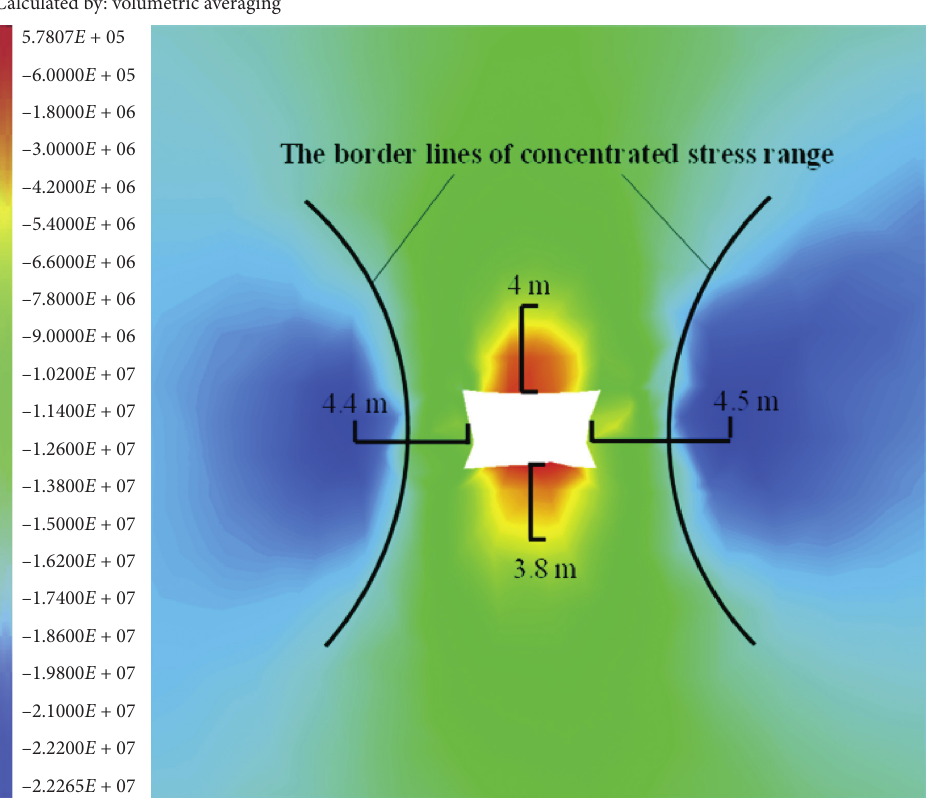
Figure 7: The vertical stress distribution of surrounding rock in complex high-stress roadway.